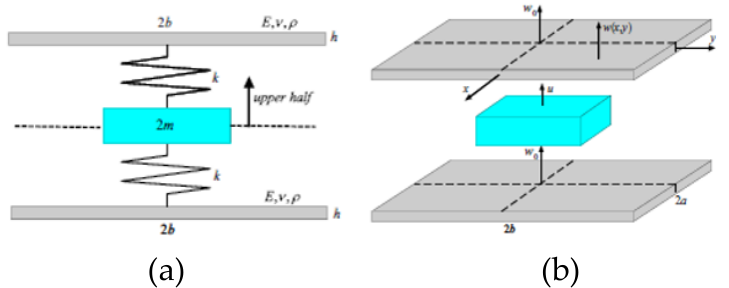
Figure 1. A unit cell of a typical acoustic metamaterial plate: ( a ) front view; ( b ) perspective view [7].